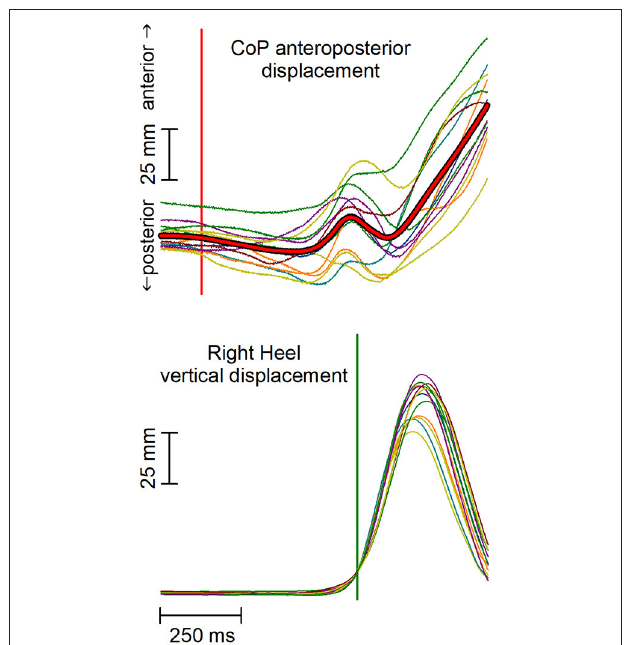
FIGURE 1 | Anterior-posterior (AP) displacement of the center of pressure (CoP) and vertical displacement of the leading heel in a representative subject. Thin traces represent single trials, which are time aligned to the heel-off (vertical green line). Red thick trace in the upper plot represents the average CoP displacement. Notably, the high trial-by-trial variability of CoP makes the automatic identification of the CoP onset difficult and error-prone in each single trial. The vertical red line marks the CoP shift onset as identified on the average CoP